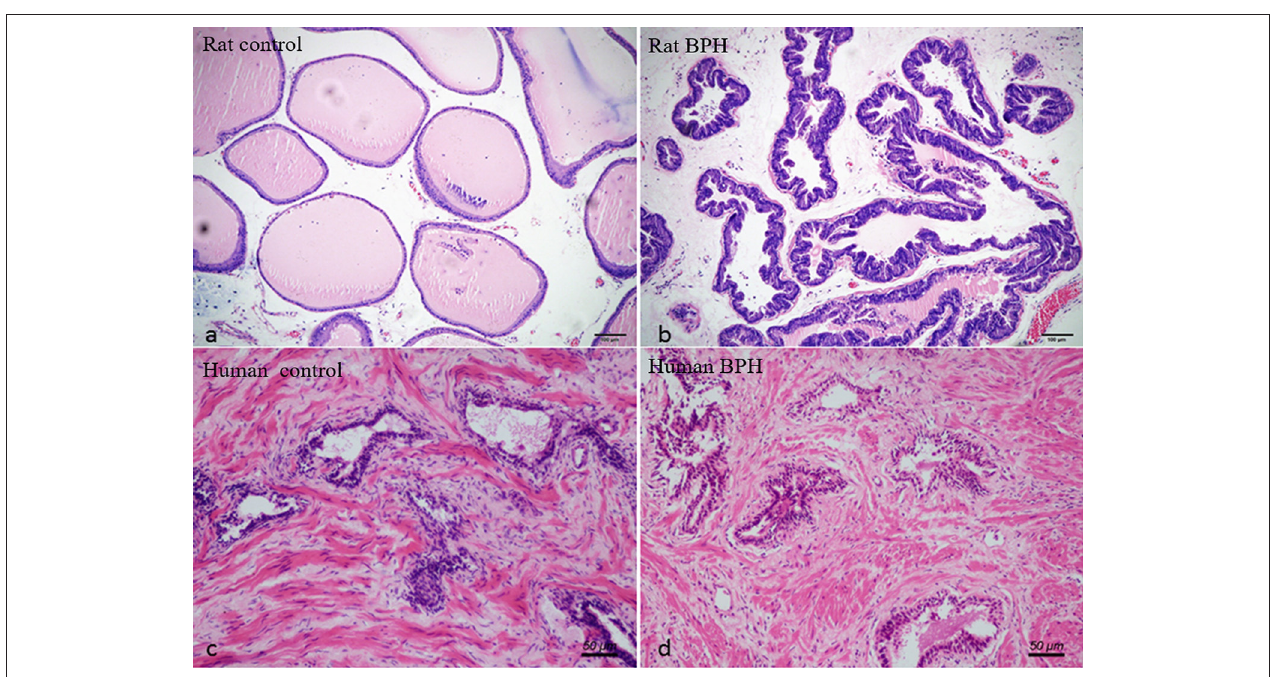
FIGURE 2 | Histological examination of prostate. H-E staining of prostate tissue. (a) Normal rat prostate. (b) BPH rat prostate. Hyperplastic prostate occurred mainly in the epithelial compartment and typical features of glandular hypertrophy were observed including papillary fronds protruded into the glandular cavities and the epithelial layer thickened. (magnification × 100). (c) Normal human prostate. (d) BPH human prostate. An obvious stromal hyperplasia was observed (magnification ×